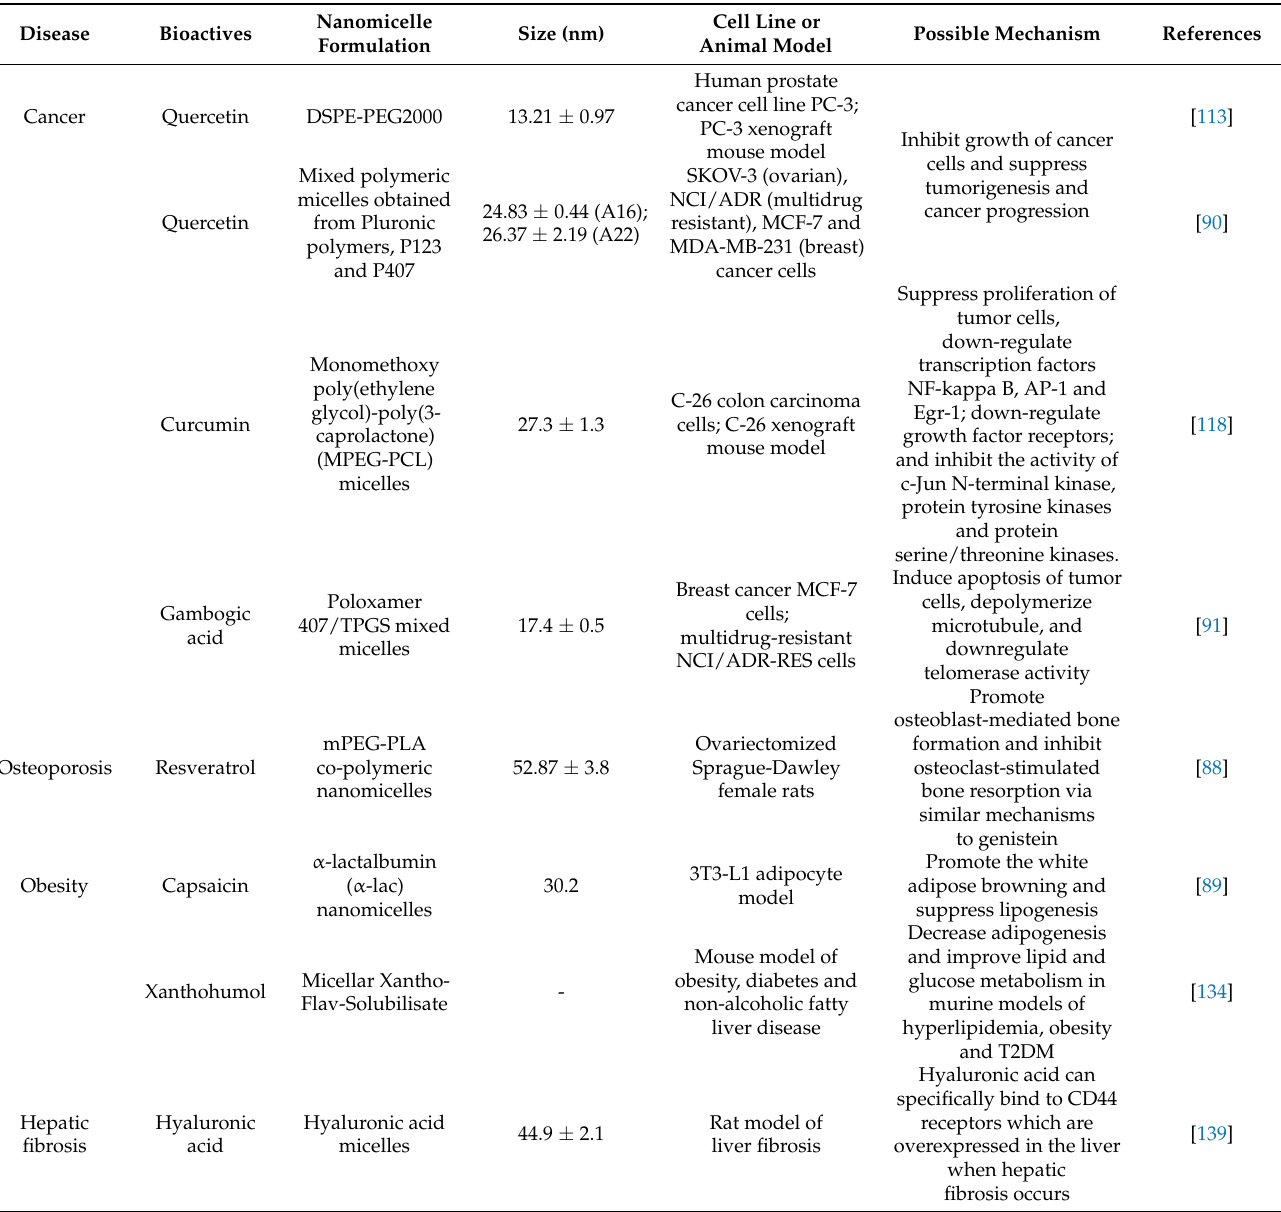
Table 2. Application of nanomicelles in delivering bioactive nutrients for disease